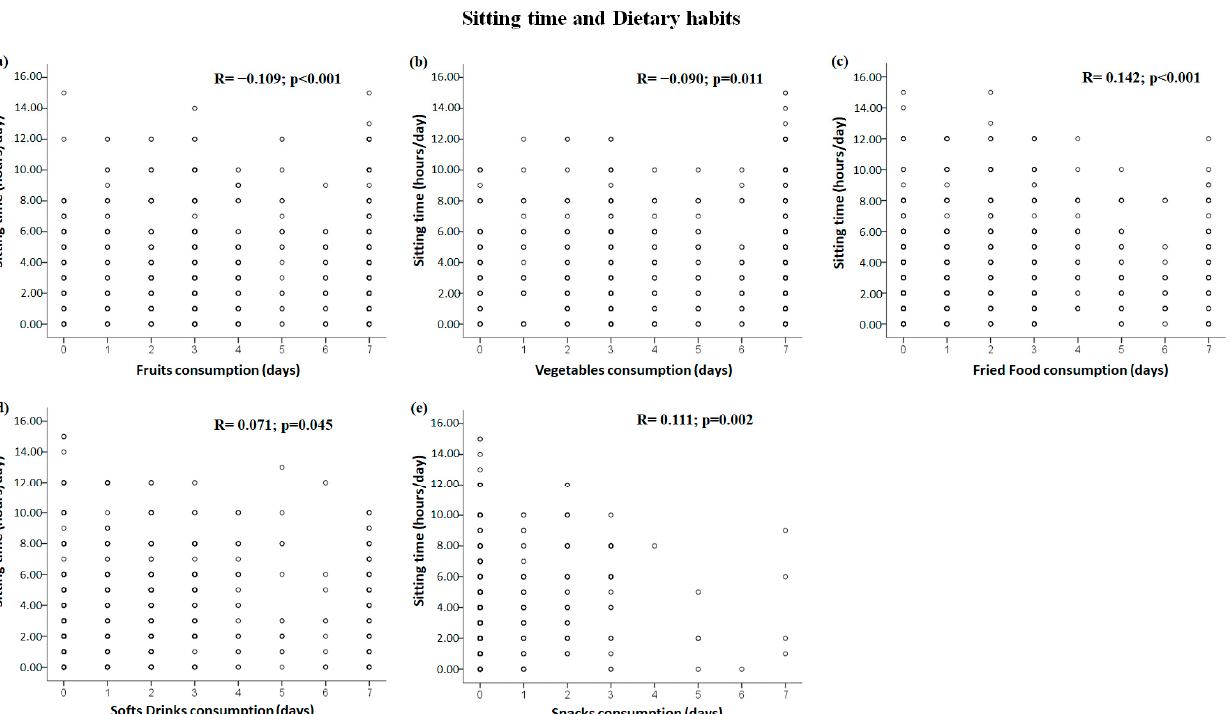
Figure 2. Significant correlations between dietary habits and sitting time domain: ( a – e ) correlations Figure 2. Signi fi cant correlations between dietary habits and si tt ing time domain: ( a – e ) correlations between si tt ing time and fruit, vegetable, fried food, soft drink, and snack consumption, respec- between sitting time and fruit, vegetable, fried food, soft drink, and snack consumption, tively.